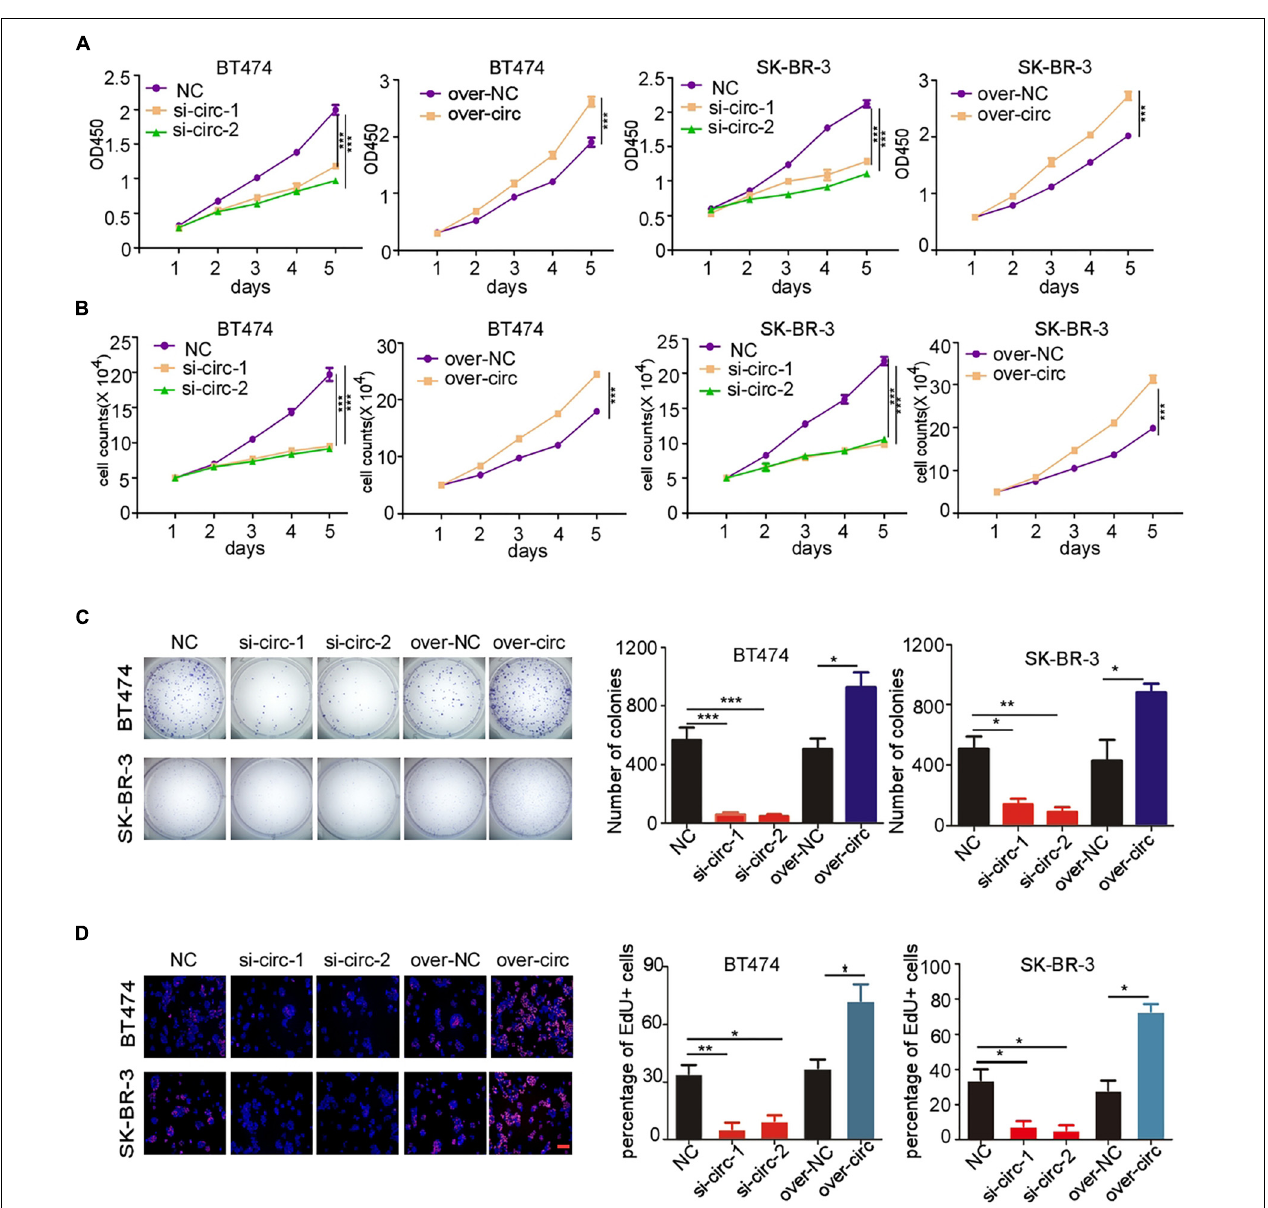
FIGURE 2 | circCDYL promotes proliferation of HER2 + BC cells. (A,B) The proliferation of SK-BR-3 and BT474 cells after silencing circCDYL or over-expressing circCDYL, as detected by CCK-8 assay (A) and cell counting experiments (B) . (C) Proliferation of SK-BR-3 and BT474 cells, as detected by plate colony formation (left) and quantitative analysis of colonies of each group (right). (D) EdU staining in SK-BR-3 and BT474 cells under siRNA or over-expressing plasmid treatment (left) and the percentage of EdU positive cell in each group (right). NC: negative control . All experiments above were repeated at least three times. * P < 0.05, ** P < 0.01, and *** P < 0.005. Error bars indicate